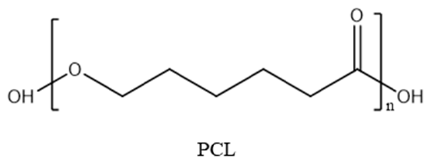
Figure 2. Structure of polycaprolactone (PCL).